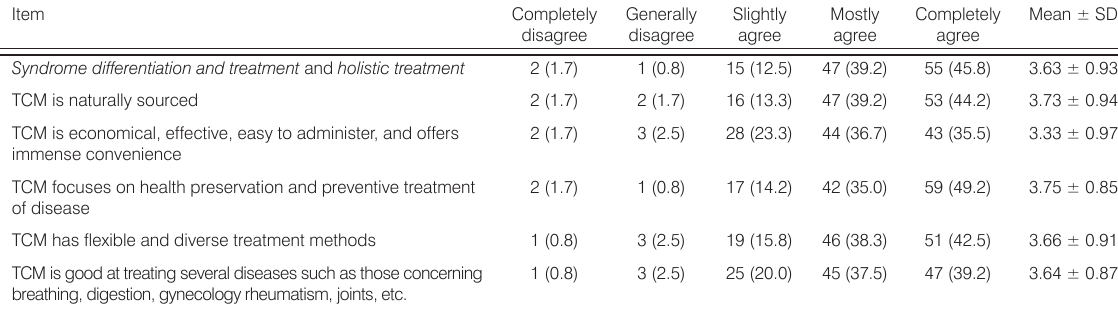
Table 2. The cognition of TCM culture and theory ( n , %).